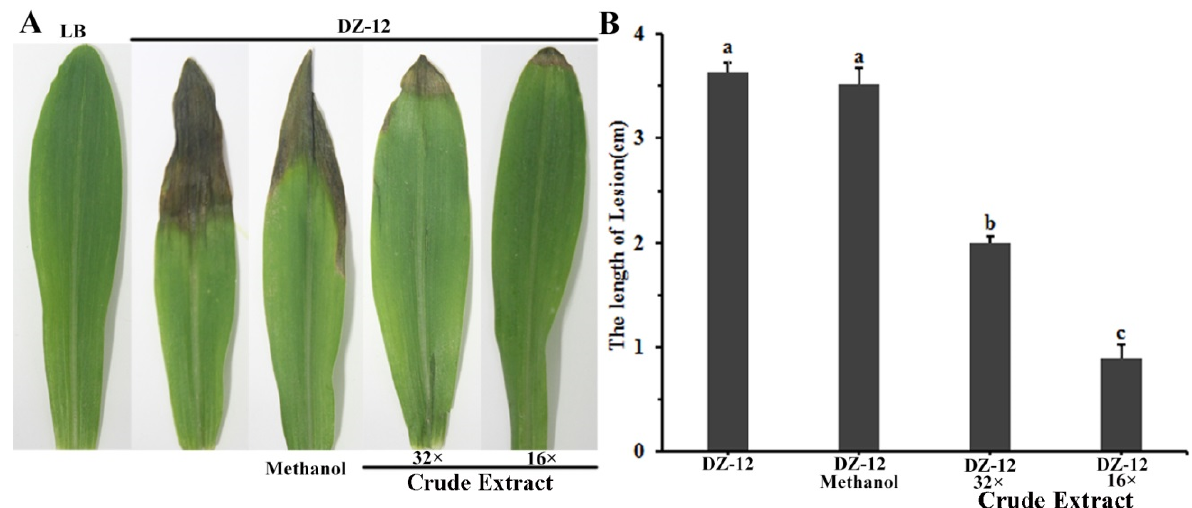
Figure 7. Crude extract from P. protegens Pf-5 influenced the infection of P. ananatis DZ-12 on maize leaves. ( A ) Disease symptom of maize plants inoculated with the DZ-12 treated with different dilutions of crude extract. Pictures were taken 7 days post-inoculation (dpi) and indicate representative results; ( B ) The graph data show the average lengths of leaf lesions ± standard deviation of three replicates. A concentration of 32× and 16× dilutions of the crude extract from P. protegens Pf-5 were used. Different letters represent statistically significant differences according to the one-way ANOVA test ( p < 0.05).